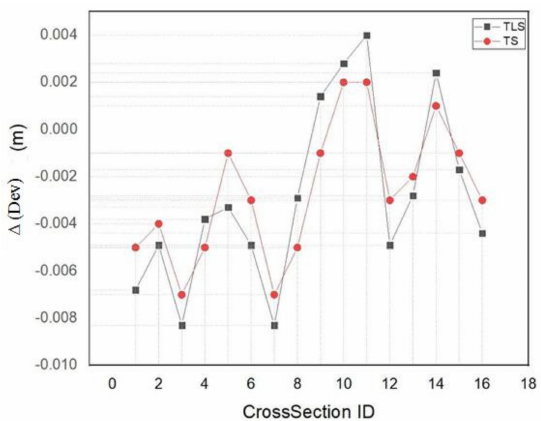
Figure 12. Deviation using the different